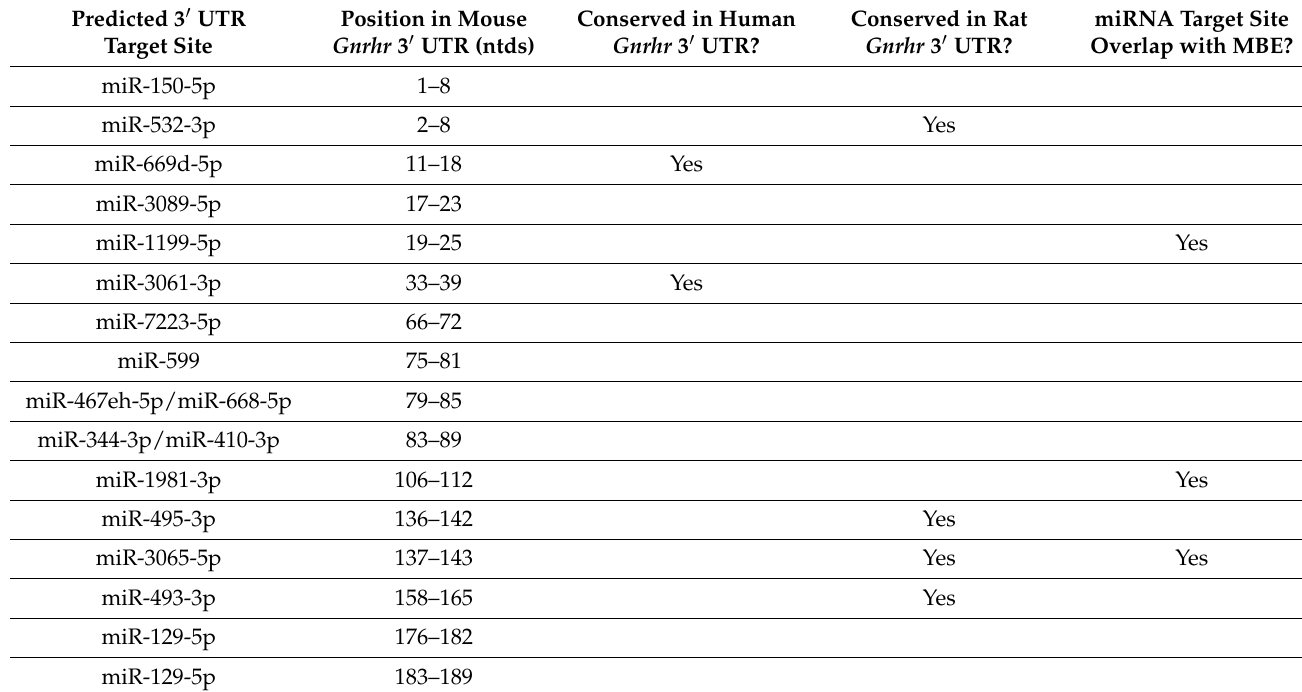
Table 1. miRNAs predicted to bind the murine Gnrhr 3 (cid:48)